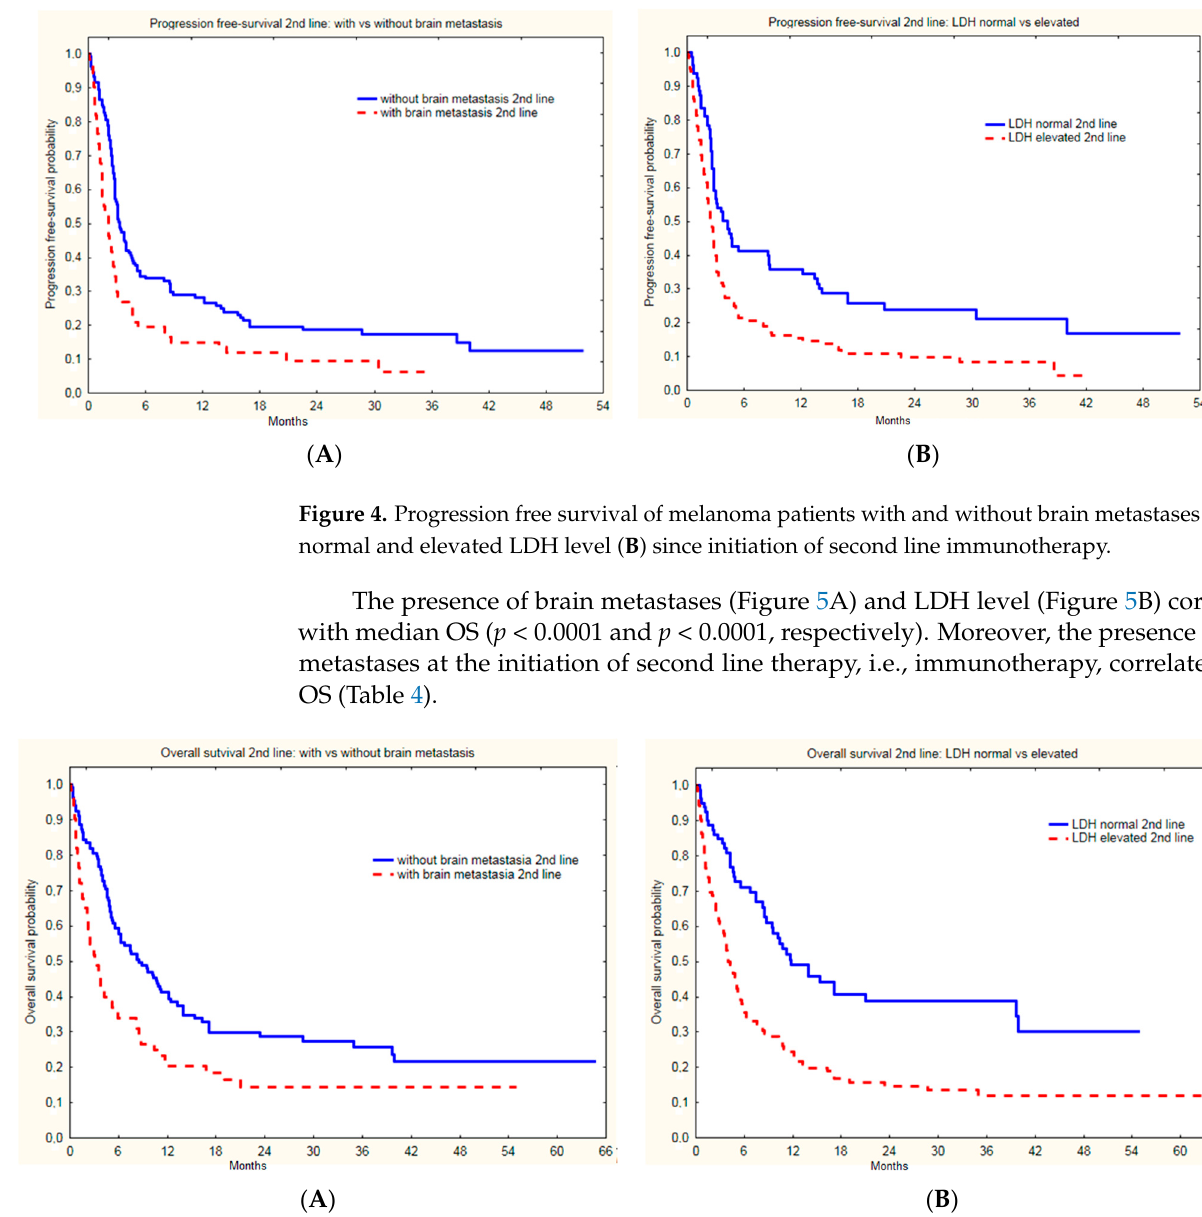
Figure 5. Overall survival of melanoma patients with and without brain metastases ( A ) and normal and elevated LDH level ( B ) since initiation of second line immunotherapy. ratio; CL, confidence interval.